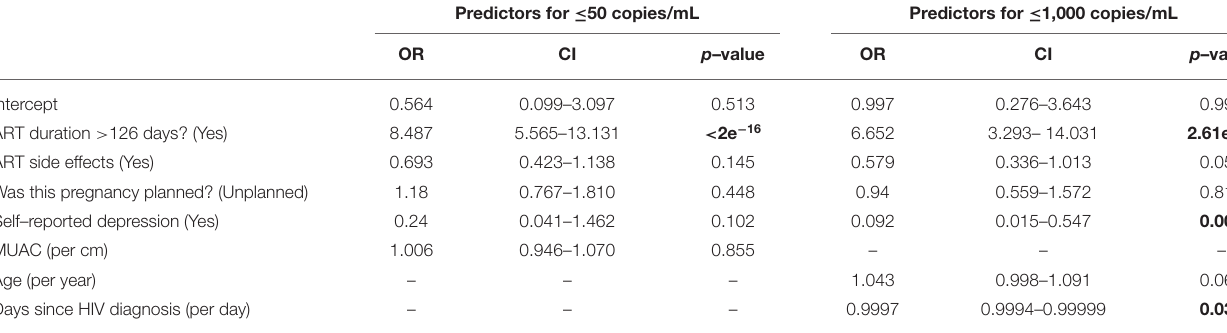
TABLE 5 | Predictors of virological outcomes for women on ART with variable